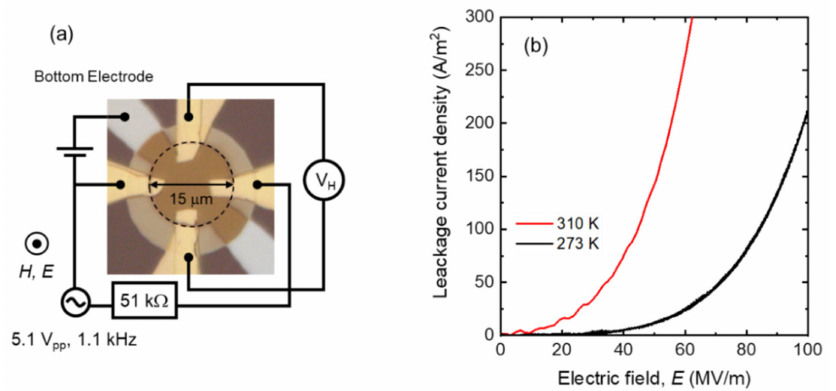
Figure 3. ( a ) Optical microscope image of the device used for the test and the electric circuitry. ( b ) I - V curves of the Cr 2 O 3 layer measured at 310 K (red) and 273 K